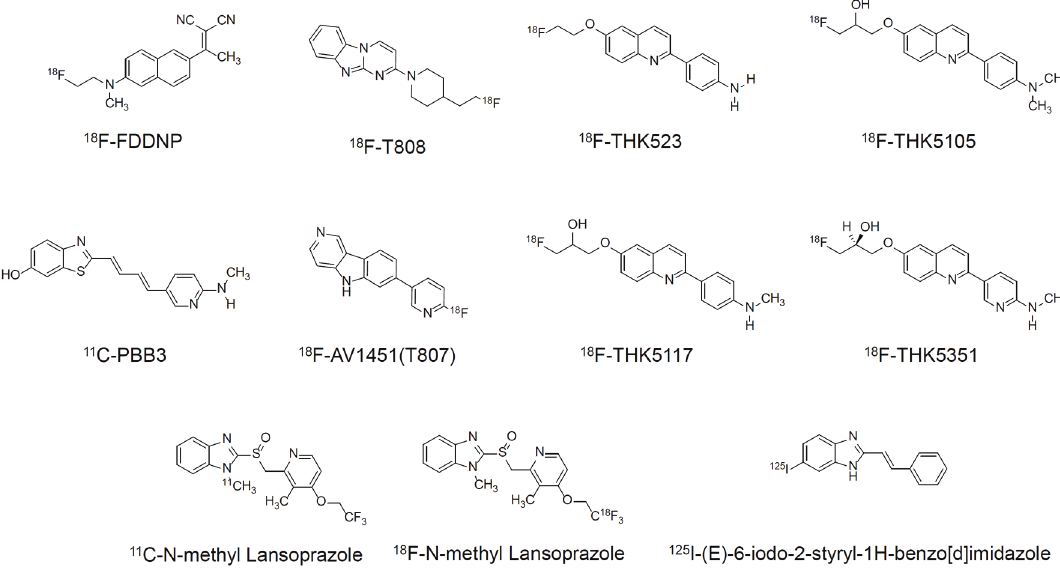
Figure 1. Chemical structures of different chemotype classes of tau ligands.